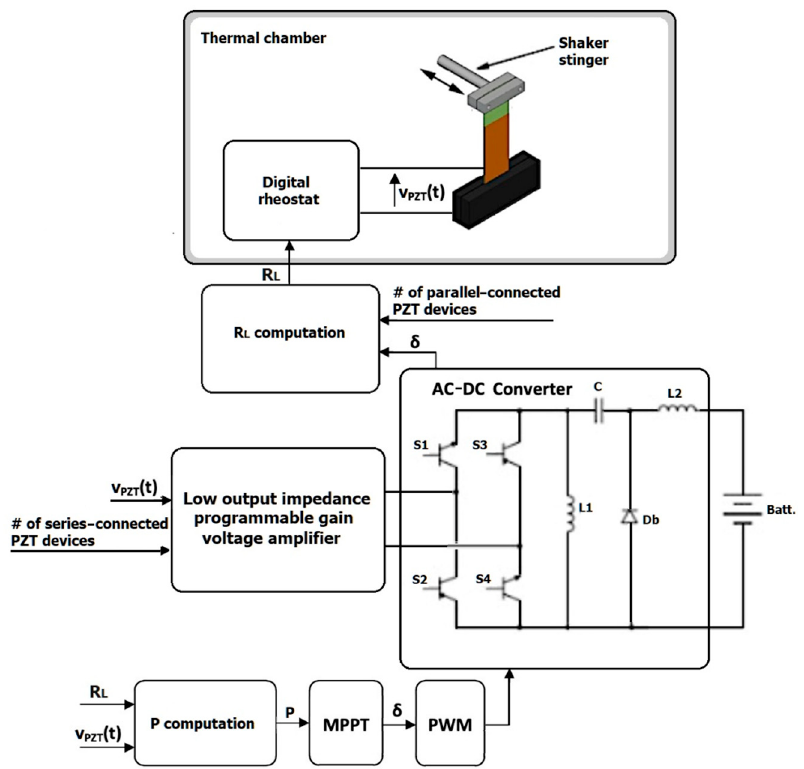
Figure 10. Schematic representation of the operating principle of the proposed active control strategy based on a single-stage DC–DC converter.